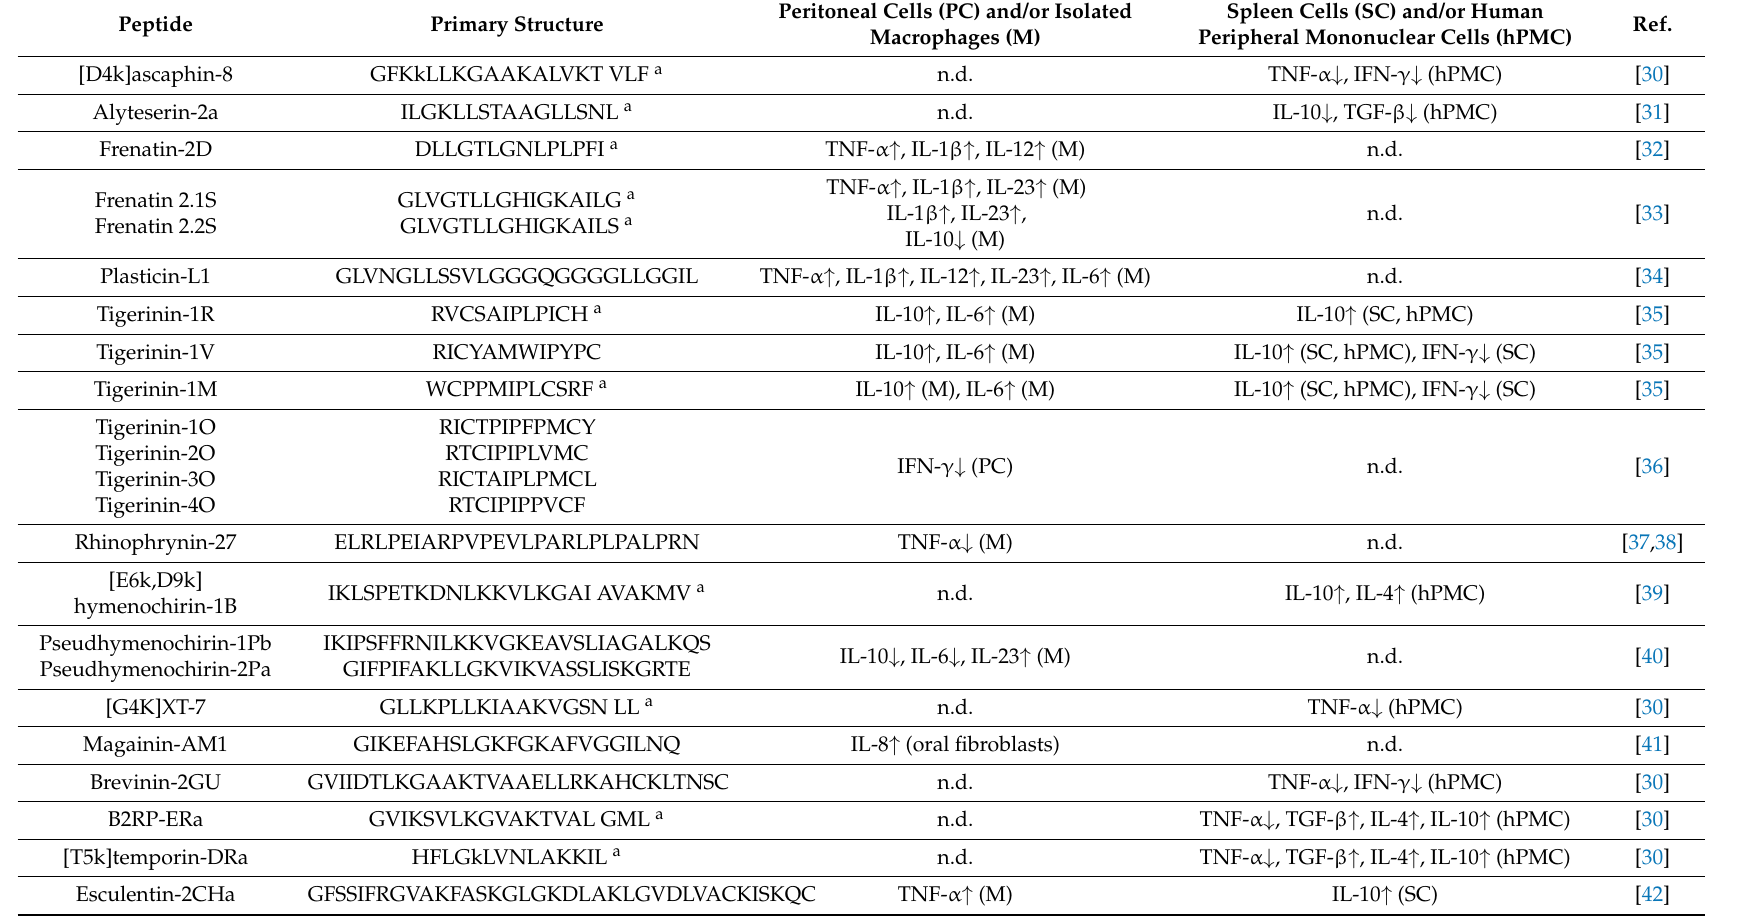
Table 2. Diverse effects of frog skin-derived peptides on cytokine production by human and murine